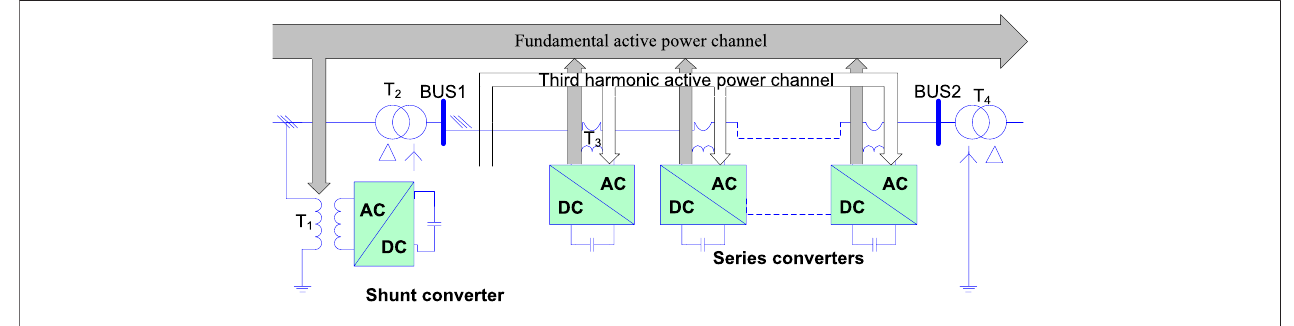
FIGURE 1 | Con fi guration and principle of the DPFC